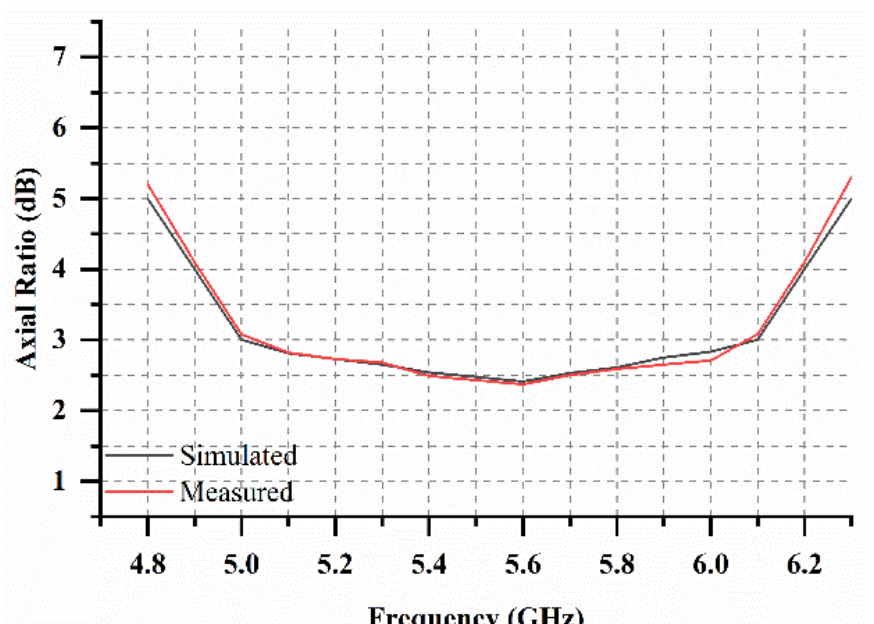
Figure 14. Simulated and measured axial ratios.